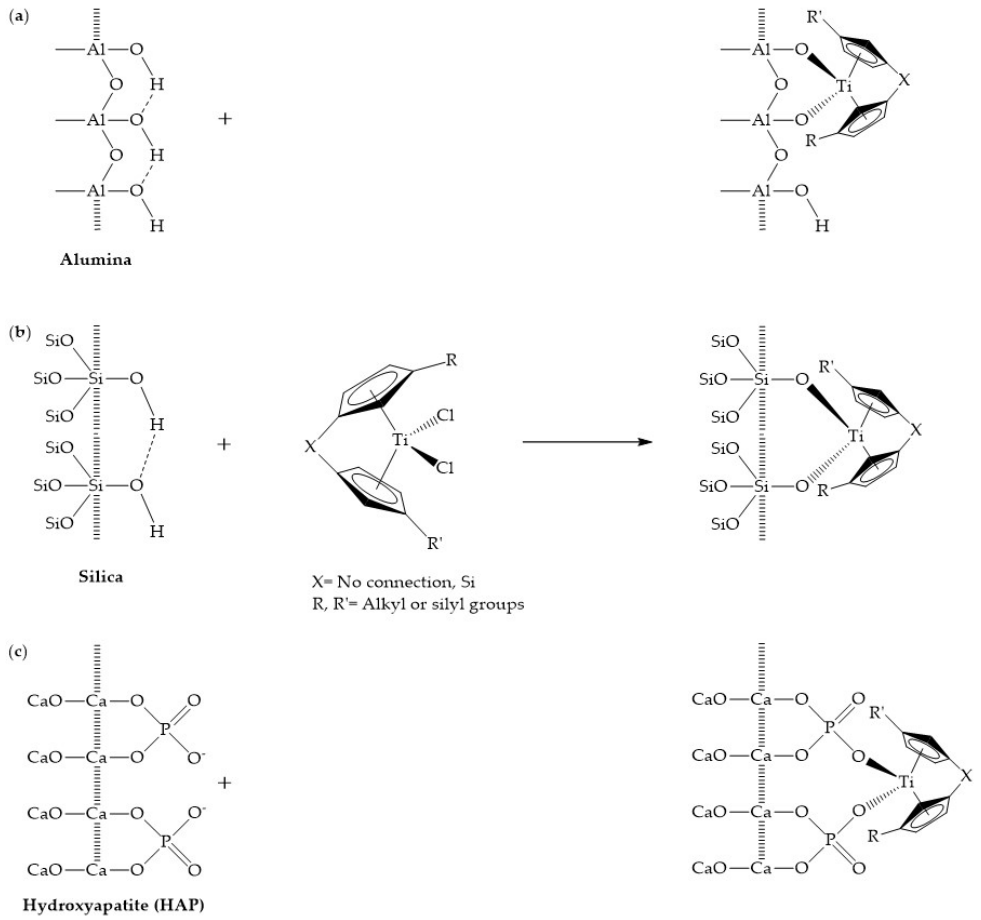
Figure 8. The titanocenyl moiety coordinating onto alumina ( a ), mesoporous silica ( b ), and dehydroxylated hydroxyapatite (HAP) ( c